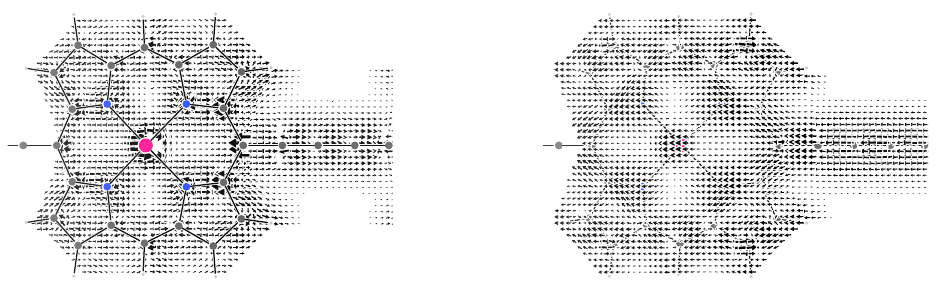
6 + nanoring on a surface having the molecular B Figure 4. Current density plotted 1.2 au inside ( A ) and outside ( B ) the c-P6